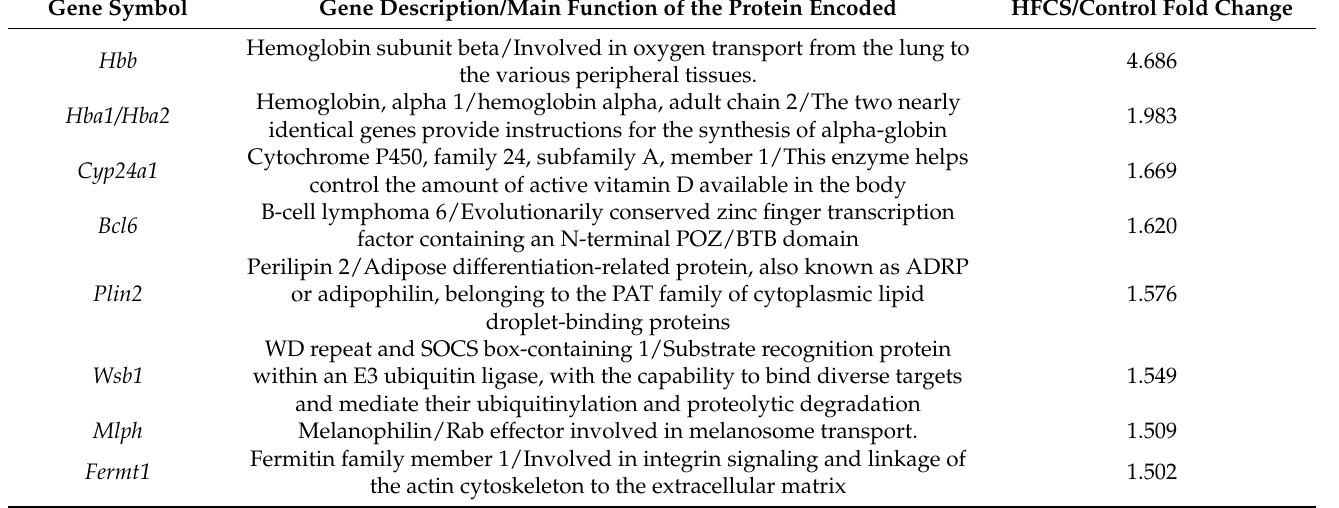
Figure 2. Quantitative analysis of serum toxic advanced glycation end product (TAGE) levels ( A ) and intracellular TAGE levels in the liver ( B ) in the high-fructose corn syrup (HFCS) and control groups of rats. Data are presented as the mean ± standard deviation ( n = 10). * p < 0.05 HFCS versus control group (Mann-Whitney U -test). Table 1. Upregulated genes in the high-fructose corn syrup (HFCS) versus control group ( n = 3 each) based on microarray